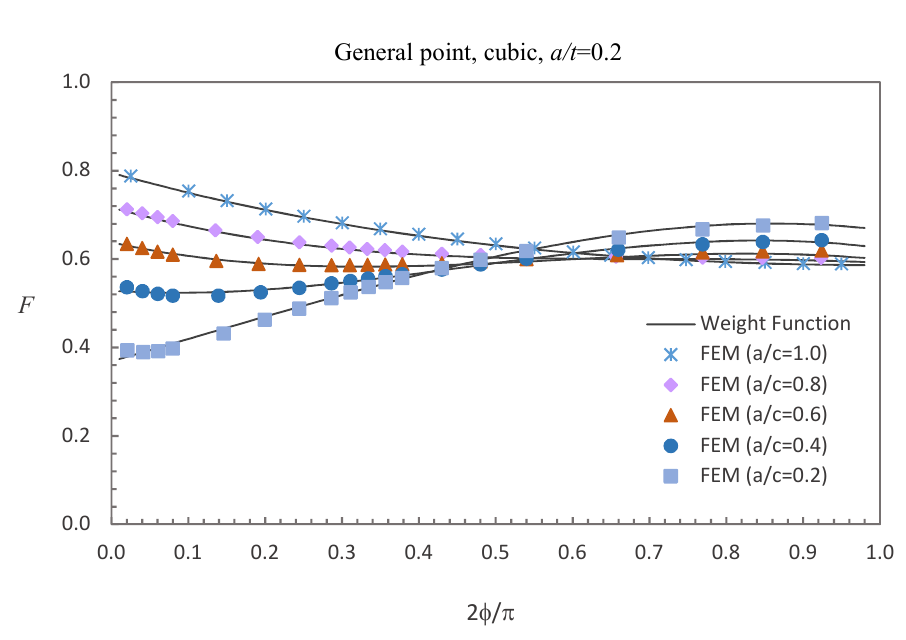
Figure 9. Comparison of weight function and FE results in this study with cubic stress distribution (deepest point).